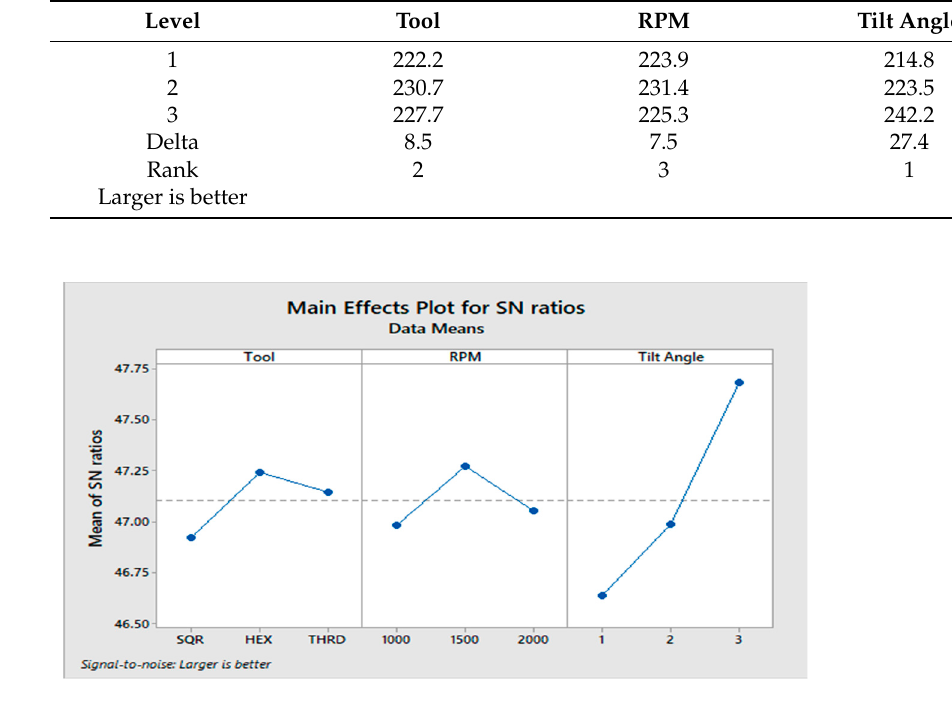
Figure 8. Main effects between the mean of SN ratio and process parameters.